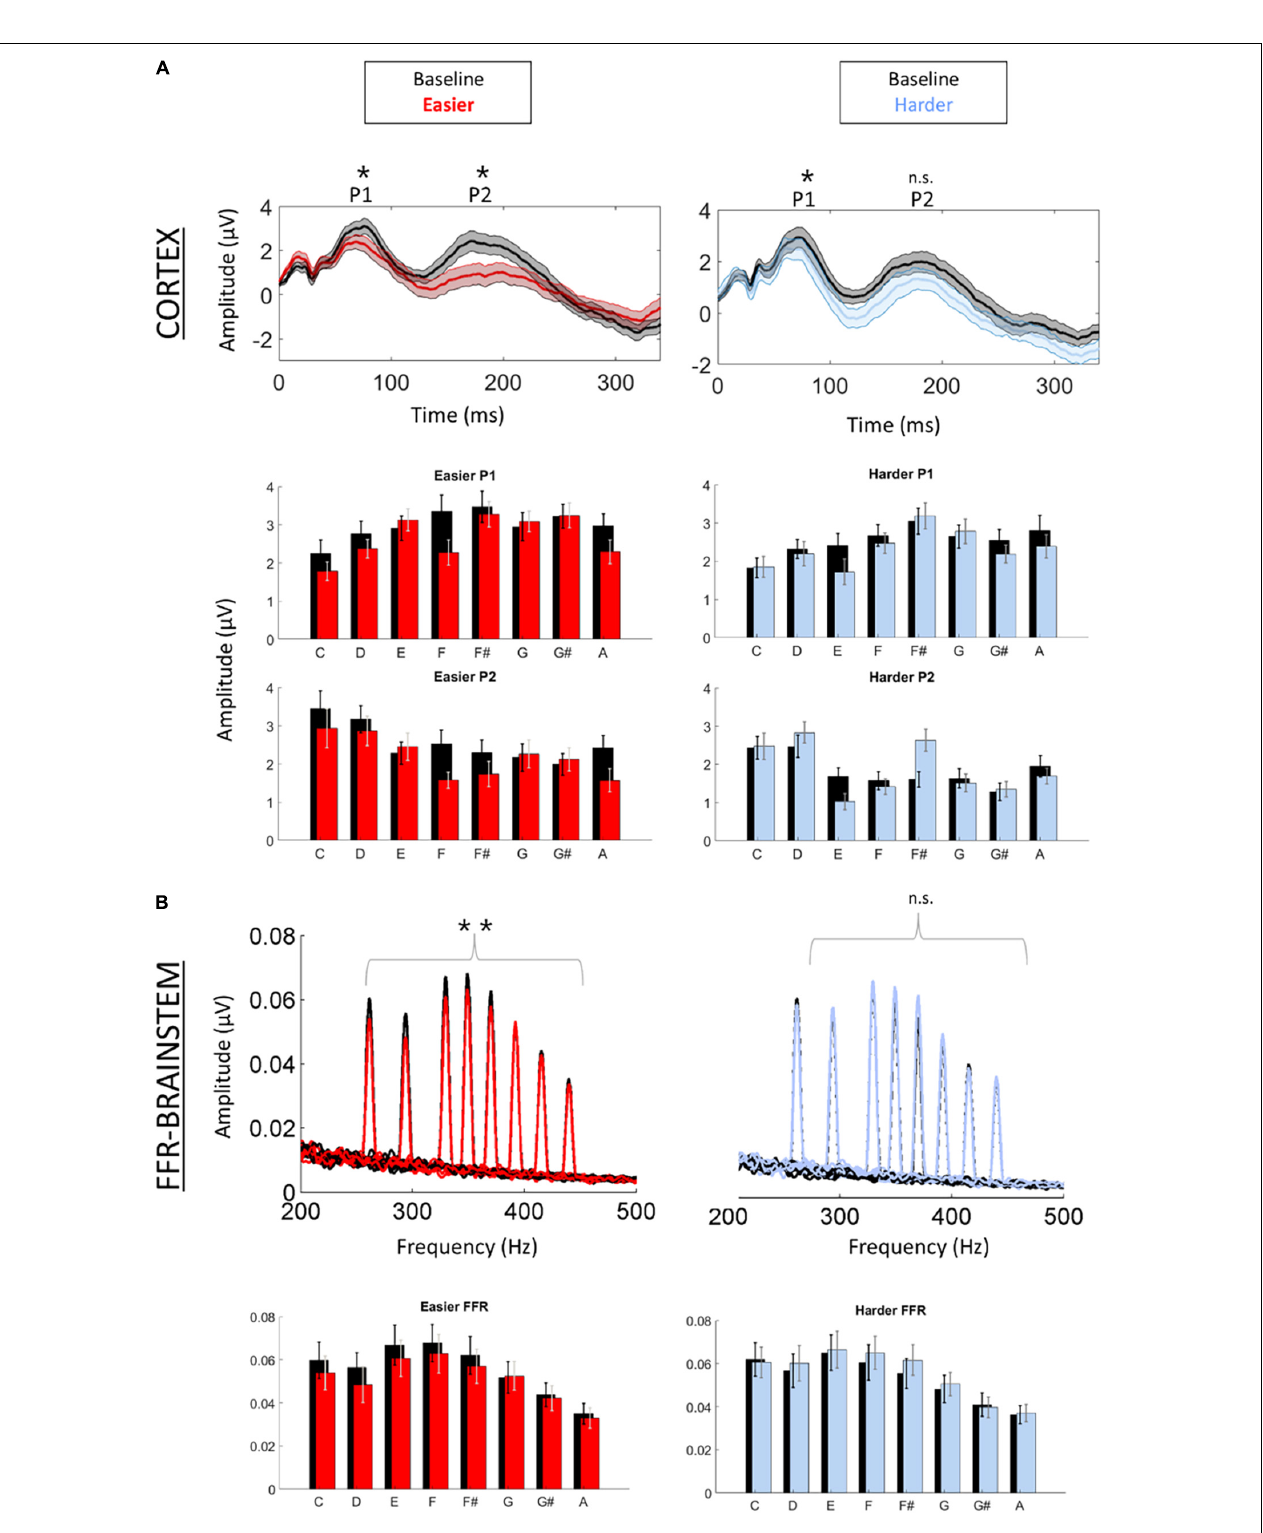
FIGURE 2 | Cortical (A) and brainstem (B) responses were recorded simultaneously while participants listened to a baseline (unpatterned) condition (black) followed by a patterned condition (red = easier, blue = harder). (A) Time-domain cortical evoked potentials are plotted for the baseline and patterned conditions (averaged across all tones). Shading represents + /1 standard error of the mean (SEM) amplitude. Peaks P1 and P2 are labeled. Bar graphs of the mean amplitude for each tone for P1 and P2 are plotted below the time domain waveforms. Error bars represent ± 1 SEM. (B) Brainstem frequency-following responses are plotted for each of the eight tones across both conditions. Bar graphs of the mean amplitude of the FFR for each tone are plotted below waveforms. Error bars represent ± 1 SEM. * p < 0.05; ** p < 0.01.